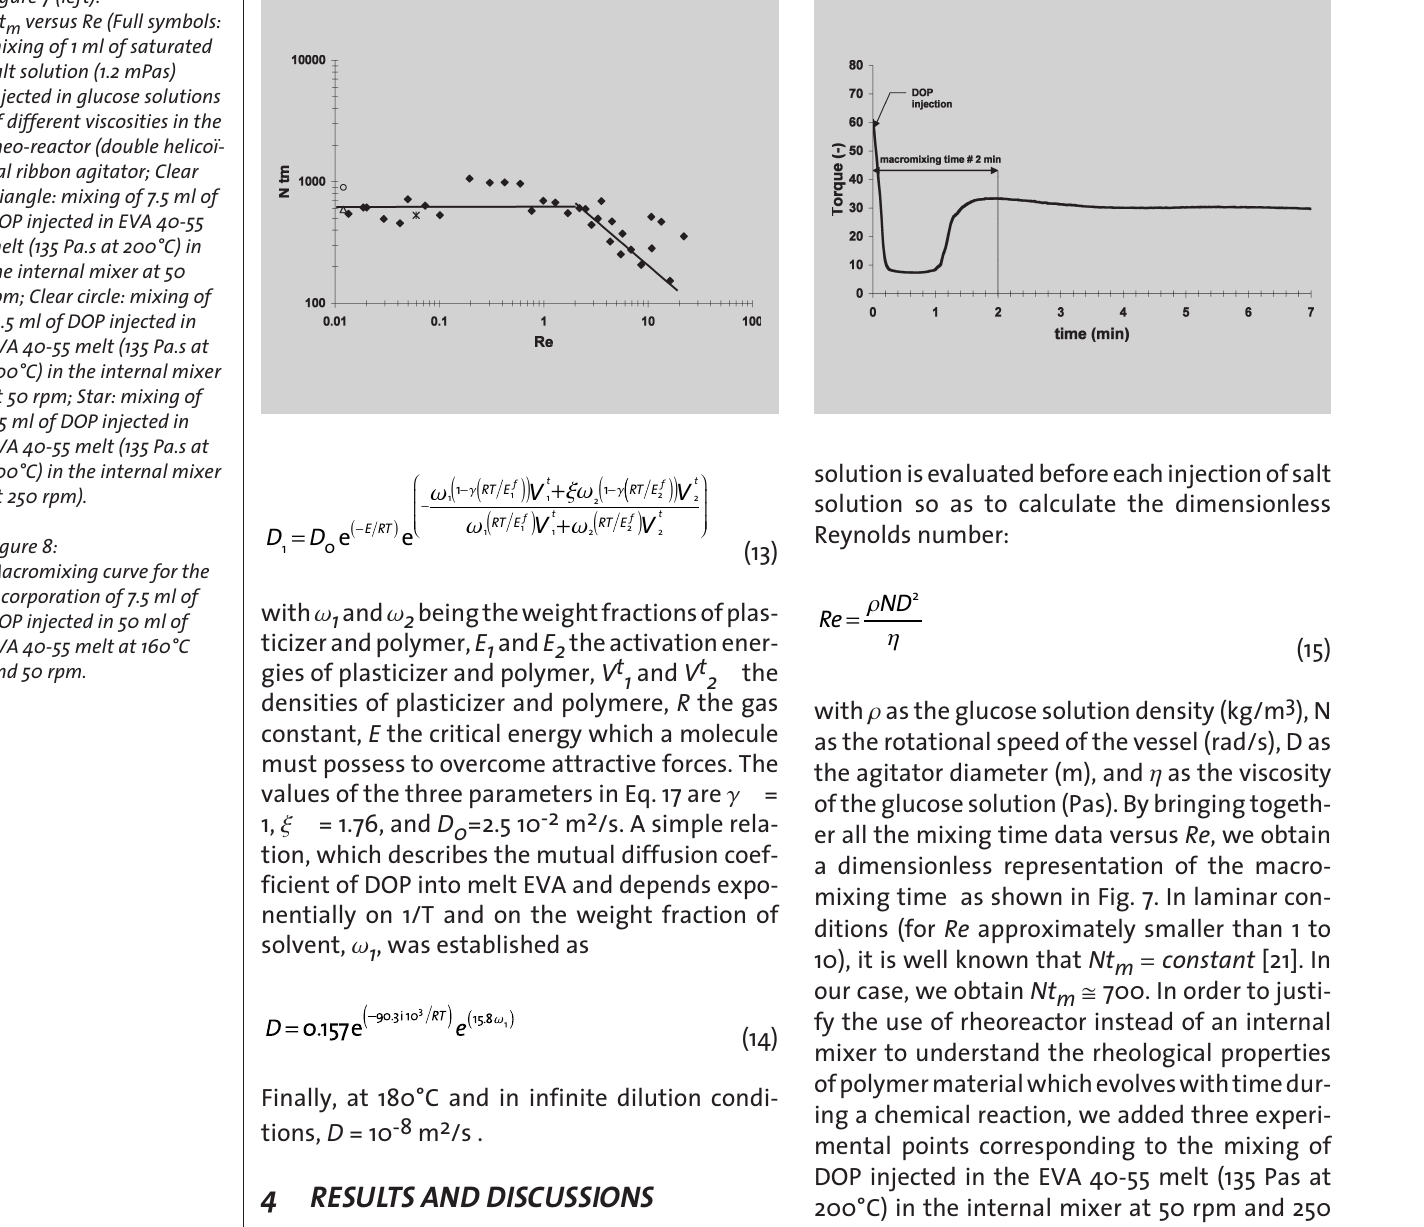
solution is evaluated before each injection of salt solution so as to calculate the dimensionless Reynolds number: